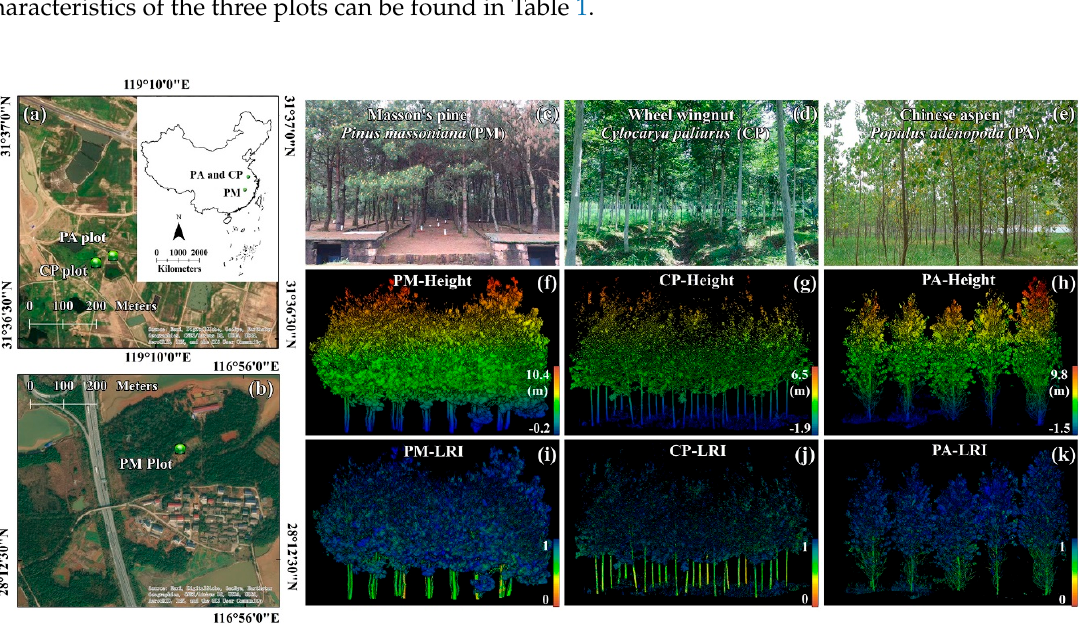
Figure 1. The study area. The subfigures ( a ) and ( b ) show the location of three plots (CP, PA, and PM). The subfigures ( c ), ( d ), and ( e ) are pictures of three plots. The subfigures ( f ) to ( k ) show the side views of three TLS datasets (colorized with point-wise height values and normalized LRI within [0, 1]). Table 1. Summary statistics of the three plots. The DBH means the diameter at breast height, which was measured at 1.3 m upper on the ground. The std means the standard deviation of data.